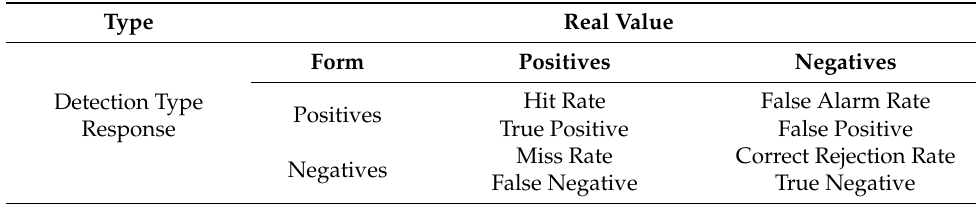
Table 3. The proposed detection matrix framework.